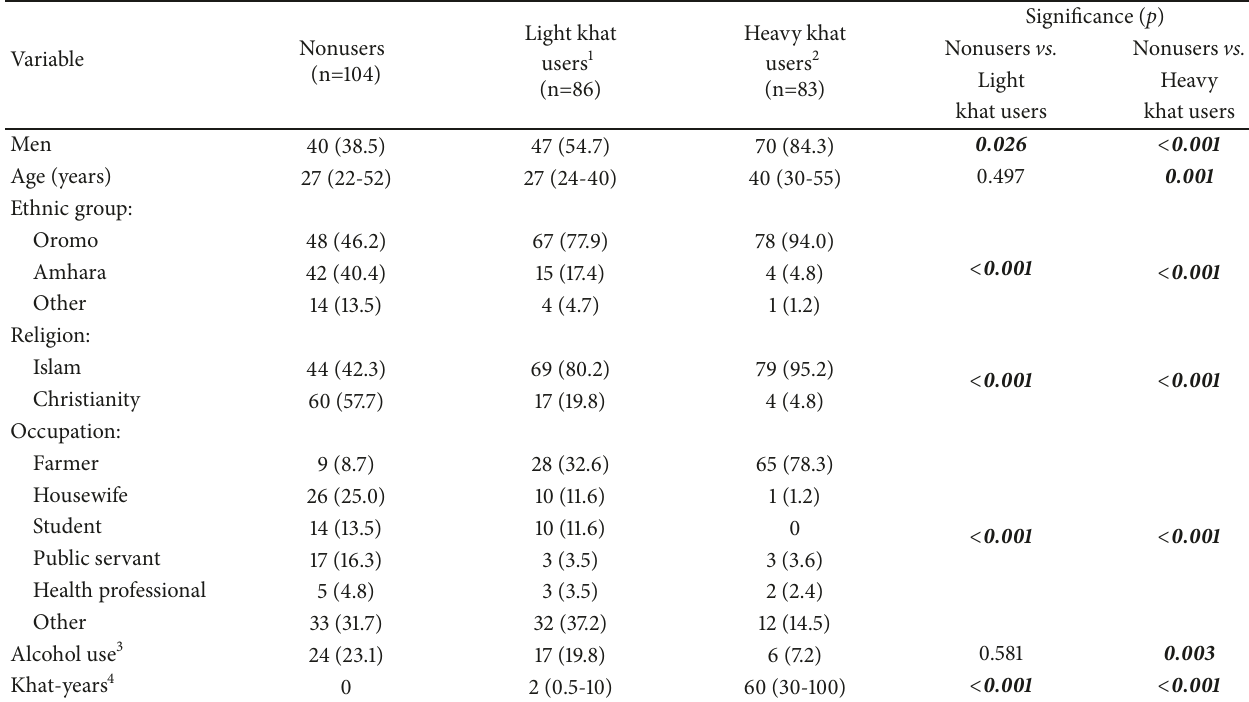
Table 1: Demographic features of the study participants, by khat consumption level.